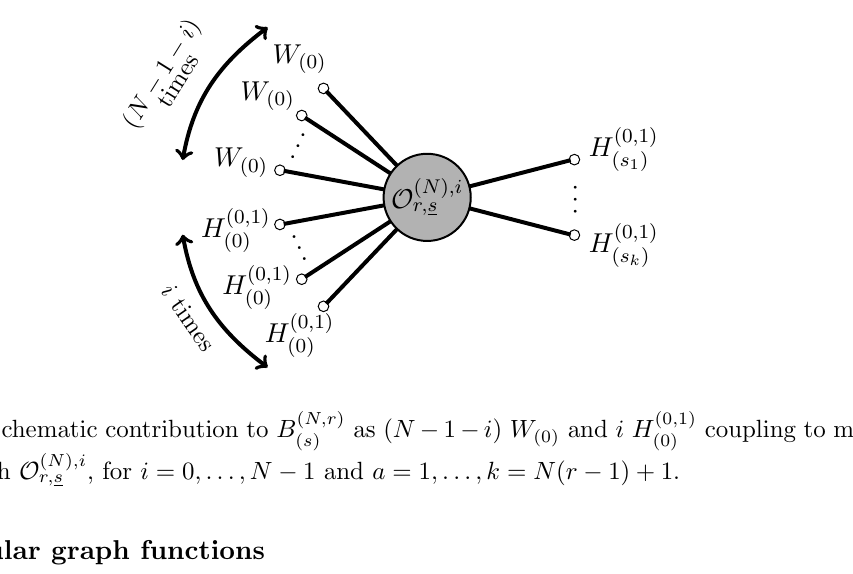
Figure 10 . Schematic contribution to B ( N;r ) H (0 ; 1) through O ( N ) ;i r;s , for i = 0 ; : : : ; N (cid:0) 1 and a = 1 ; : : : ; k = N ( r (cid:0) 1) + ( s a )